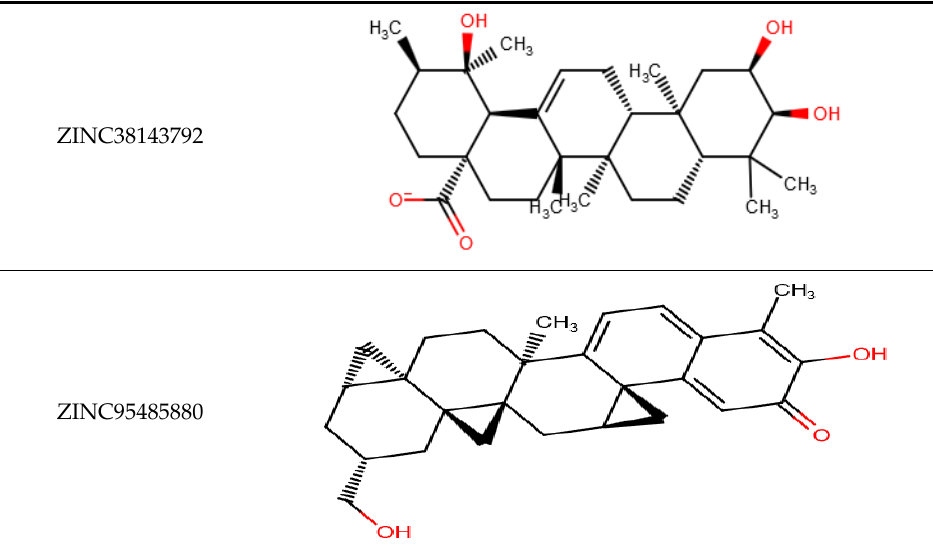
Table 6. A table showing the two-dimensional (2D) structures of three (3) selected leads generated with DrugBank (https://www.drugbank.ca/).